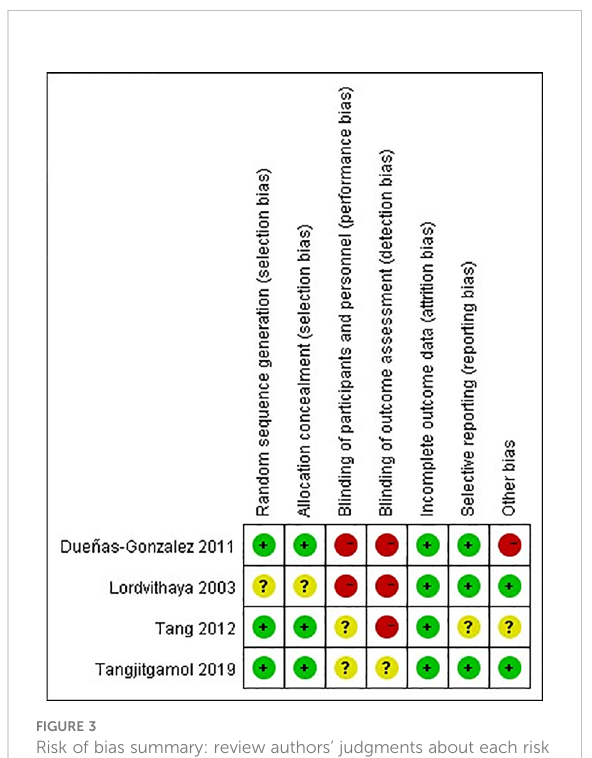
FIGURE 3 Risk of bias summary: review authors ’ judgments about each risk of bias item for